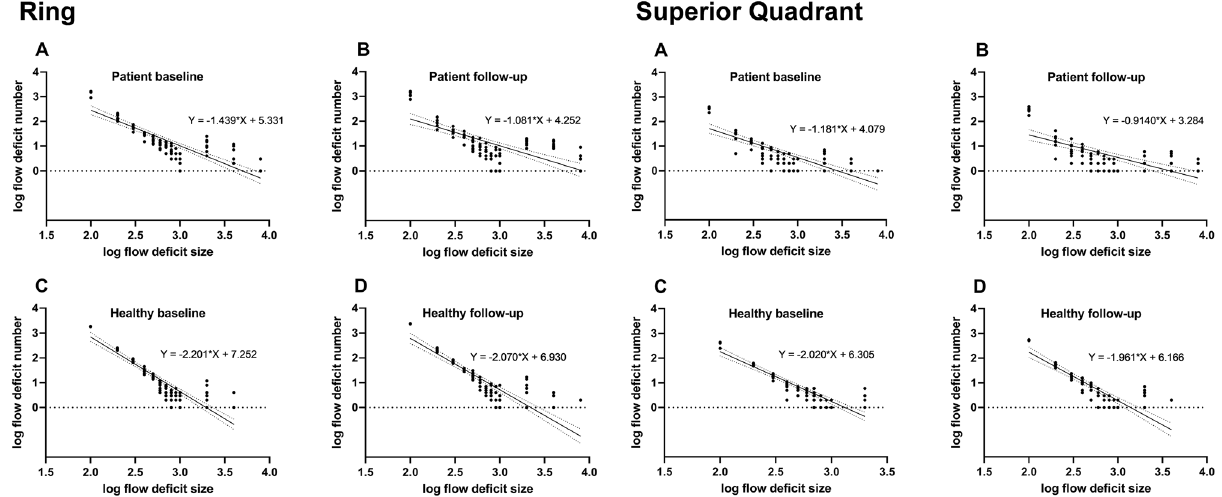
Figure 3. Baseline to follow-up changes of flow deficits shown by log–log plot with logarithmic binning in the ring area (above) and in the superior ring quadrant (below). Individual data points are shown with linear regression and 95% confidence Interval. The respective equations are given with slope (m-values) and Y-intercept (c-value).